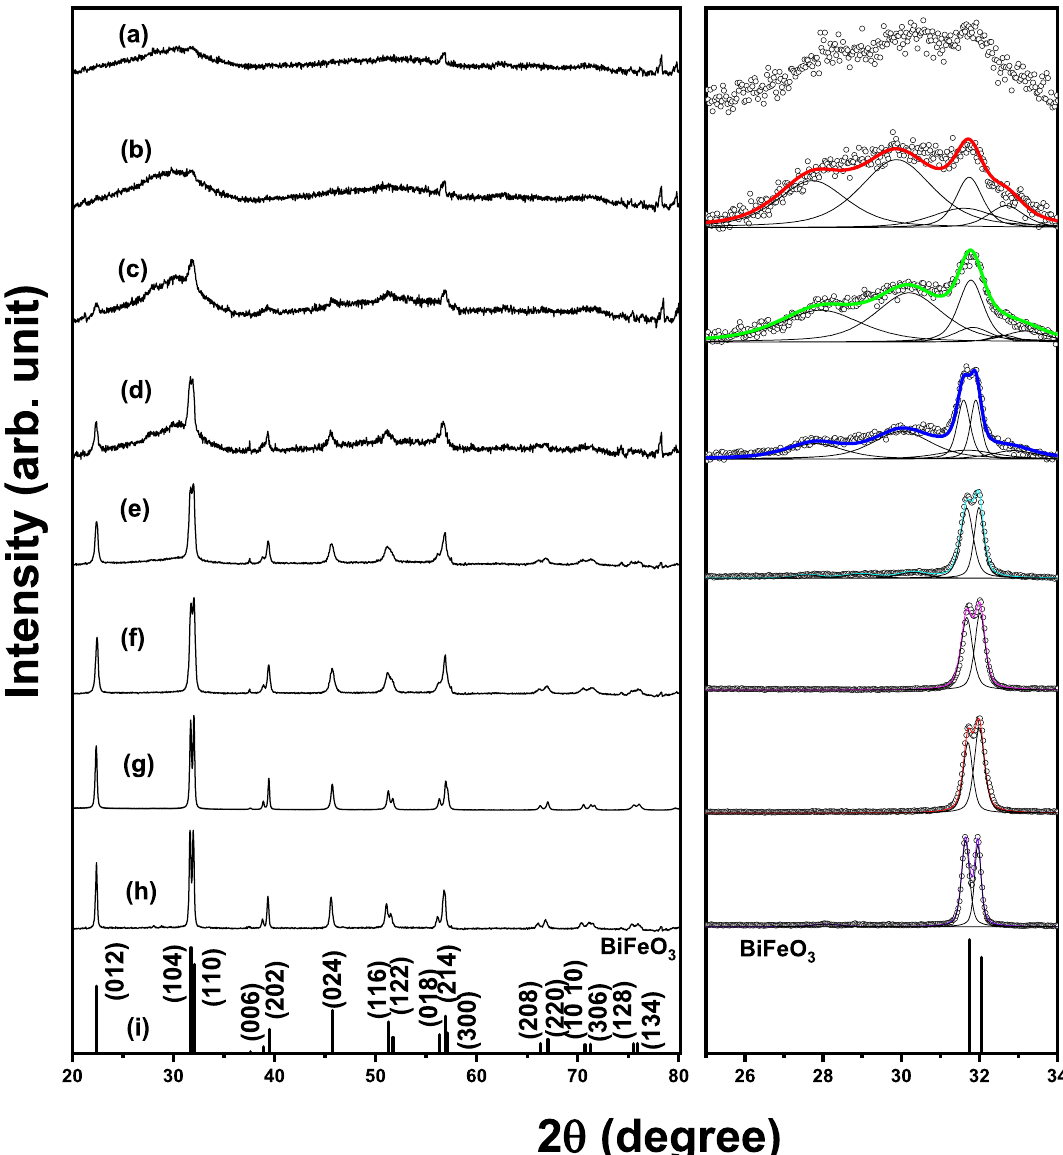
Figure 1. XRD patterns as obtained in (a) dried gel and following the calcinations of the gel in air for 2 h at the following temperatures viz., (b) 573 K, (c) 673 K, (d) 693 K, (e) 708 K, (f) 723 K, (g) 773 K and (h) 873 K and (i) stick pattern of BiFeO 3